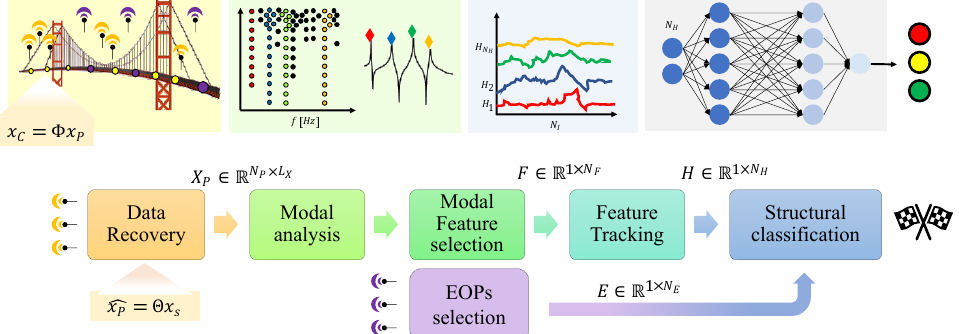
Figure 1. Proposed framework for structural assessment: From left to the right, data compression and recovery, modal feature extraction and selection with the final structural assessment block. The matrix X P is used to indicate the ensemble of CS-reconstructed signals from all the different acquisition points, as it is required by OMA algorithms to provide a global understanding of the structure under